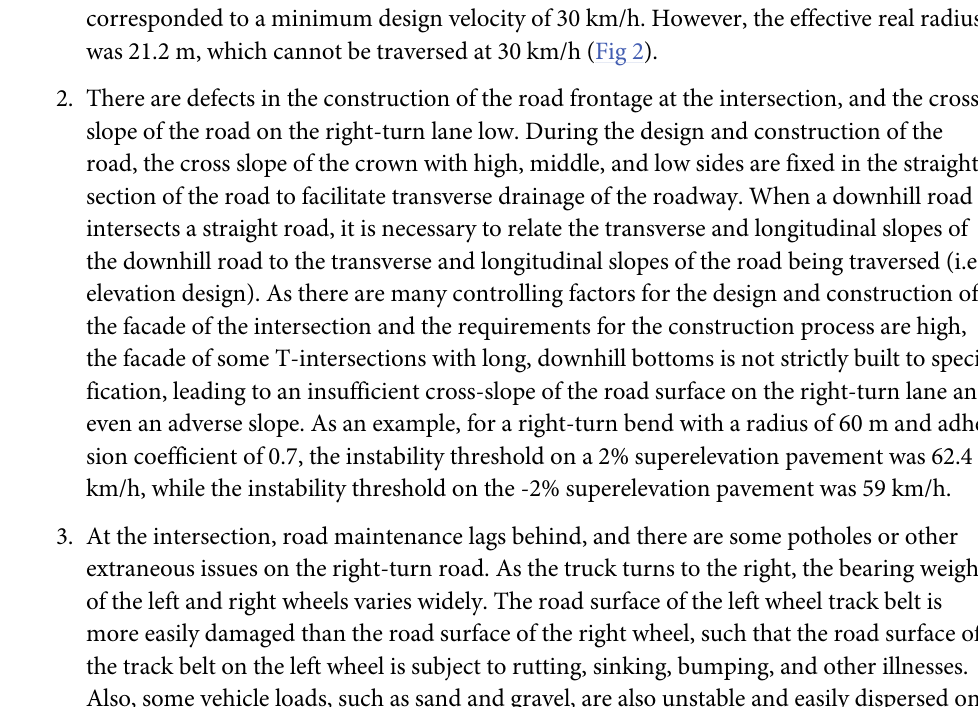
Fig 16. Fishbone diagram of cause mechanism of truck right turning instability accident at T-shaped intersection on long downhill.